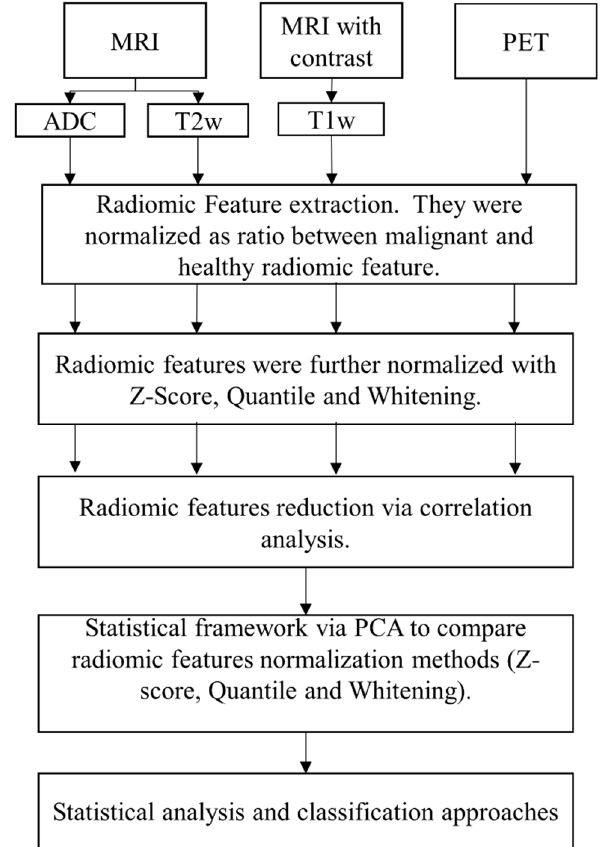
Figure 1. Analysis